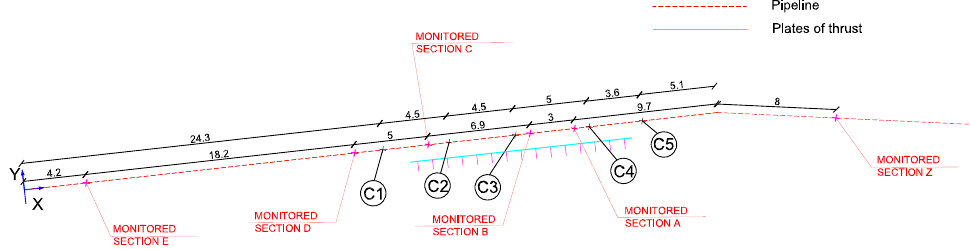
Figure 8. Plan view of the test bench (lengths in